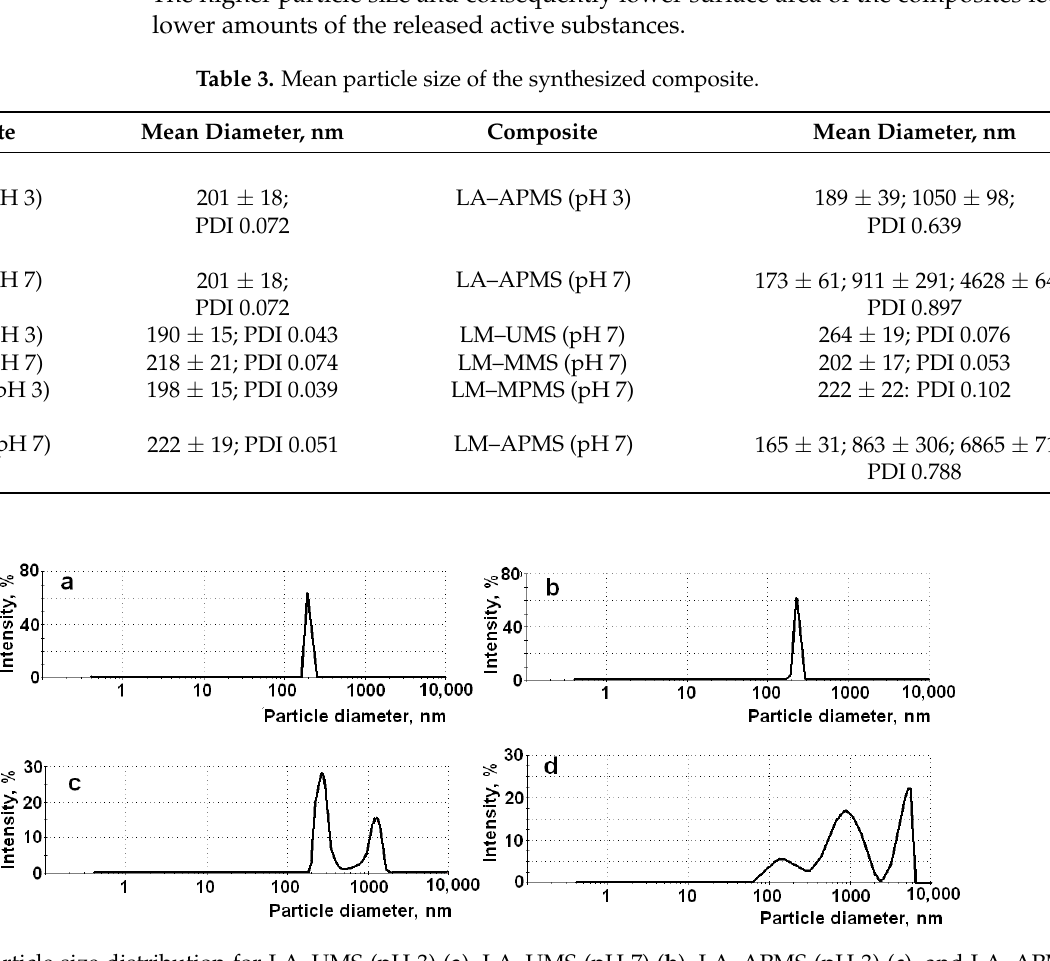
Figure 3. Particle size distribution for LA–UMS (pH 3) ( a ), LA–UMS (pH 7) ( b ), LA–APMS (pH 3) ( c ), and LA–APMS (pH 7) ( d ).